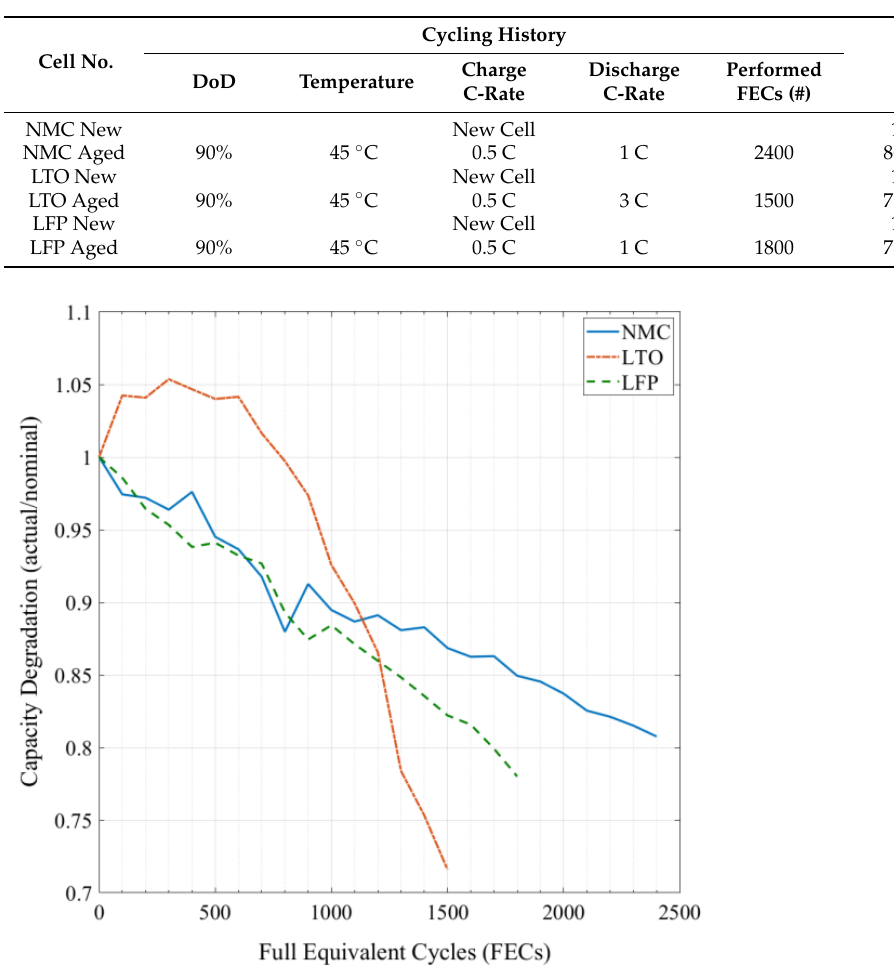
Table 2. Cell aging inventory.